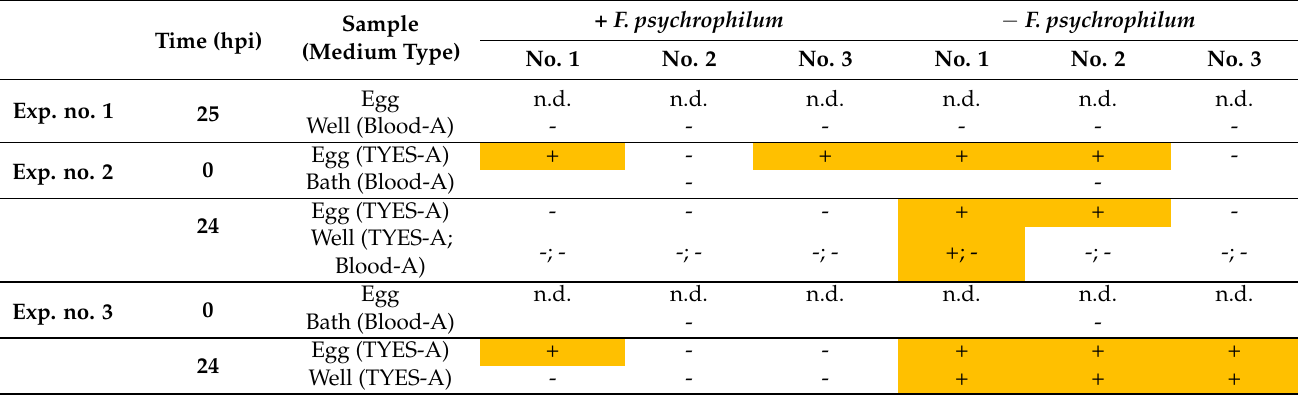
Table A2. Experiments in section A concerning F. psychrophilum. Bacterial growth other than F. psychrophilum in sampled eyed eggs and the corresponding bath/well. A plus symbol with an orange background indicates a positive detection of bacterial colonies in TYES-B and/or on Blood-A (“-” = no